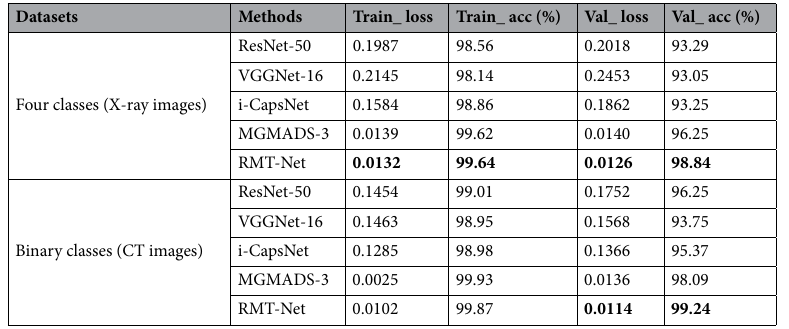
Table 2. Comparation to the other four models. Bold value highlights the gain effect of our method in the table.